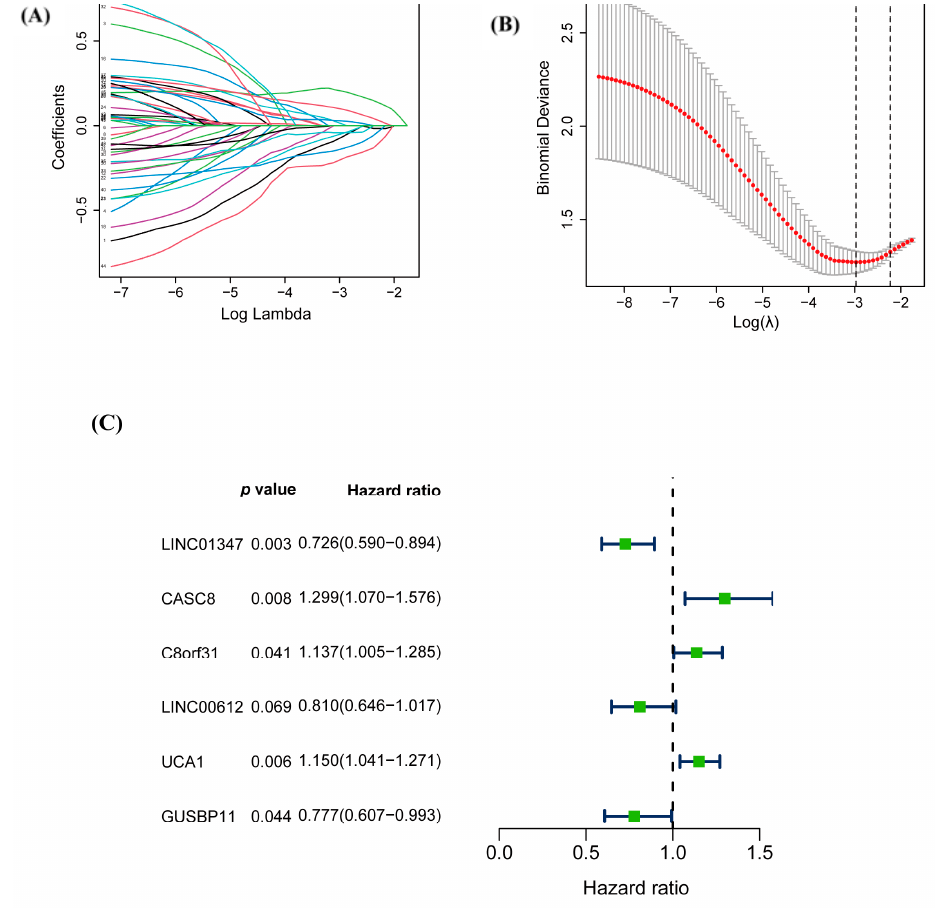
Figure 2. Construction of a prognostic signature based on warlncRNAs in PAAD patients. ( A , B ) The LASSO regression analysis ( A ) and cross-validation ( B ) were used to screen warlncRNAs. ( C ) The multivariate Cox regression analysis result indicated six warlncRNAs were identified to construct a warlncRNAs signature.